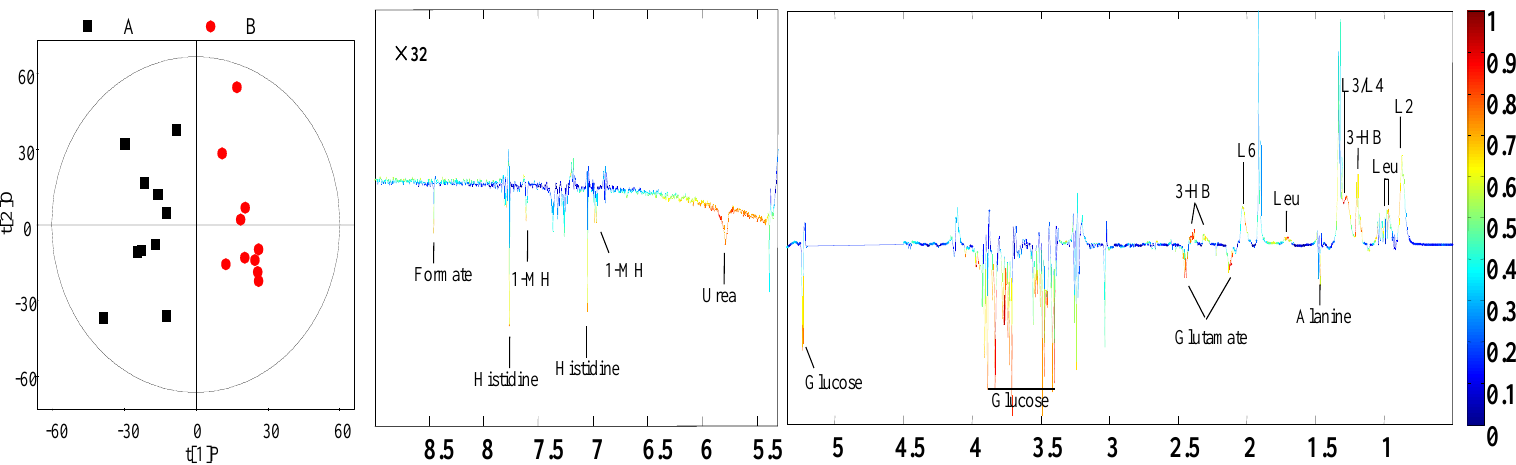
Figure 4. OPLS-DA scores plots ( left panel ) derived from the 1 H. NMR spectra of plasma and the corresponding coefficient loading plots ( right panel ) acquired from the different pairwise groups. A = heat stress group; B = thermal neutral group.